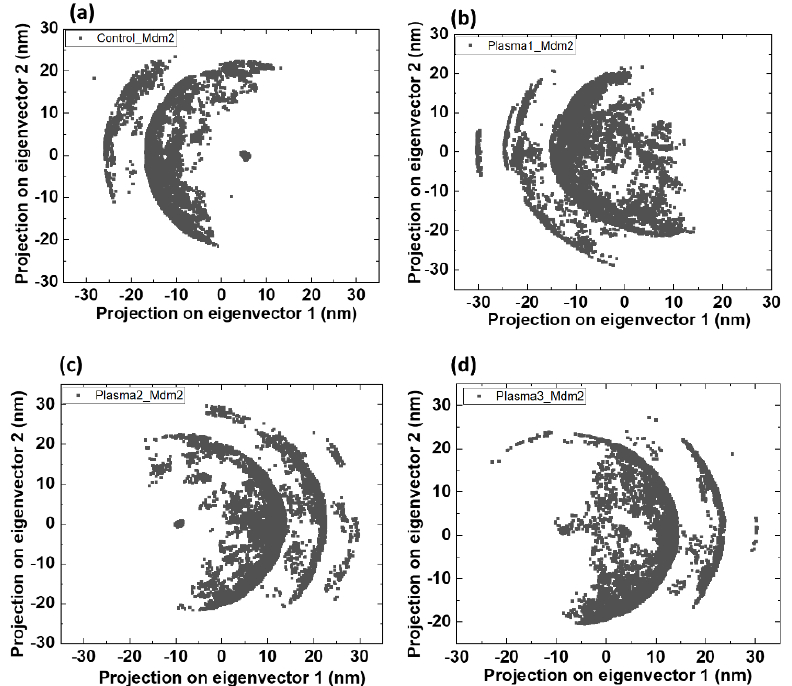
and plasma3 compared to native and plasma2; this indicated the oxidized amino acids of p53 influenced the SASA values.